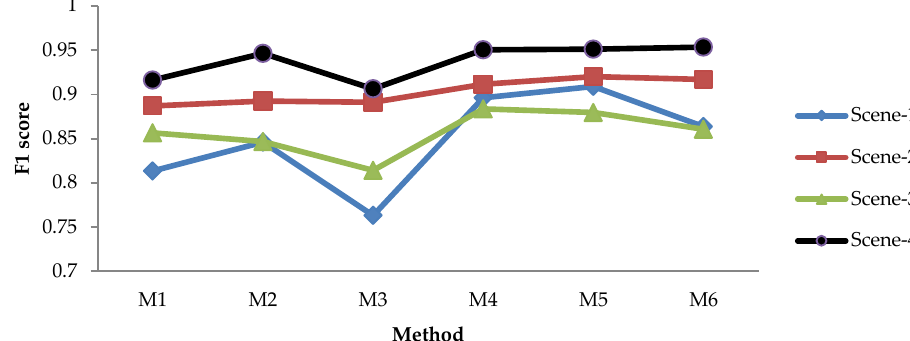
Figure 11. F1 score evaluation of static image methods from four scenes.